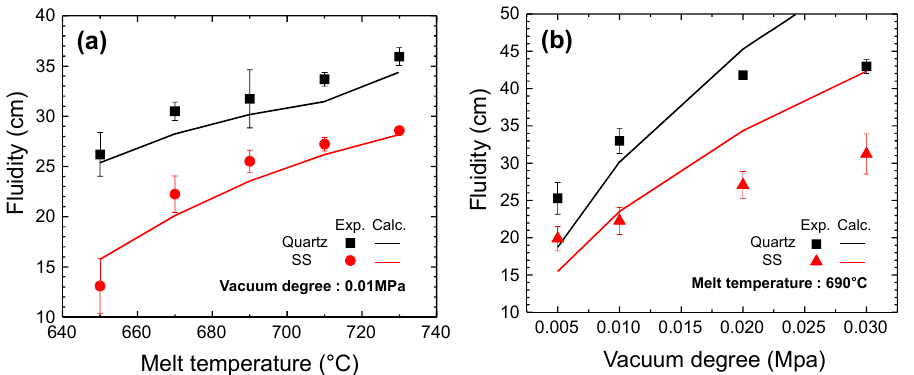
Figure 9. Comparison of the measured fluidity lengths with the calculation result of the present fluidity model at ( a ) different melt temperatures, ( b ) different vacuum